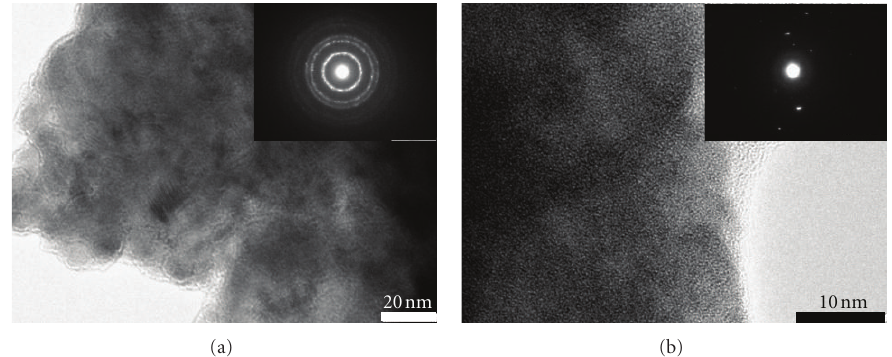
Figure 6: TEM image of spray-pyrolysis-deposited Cu-In-S with the electron di ff usion patterns (inset) on a glass/TiO 2 /In 2 S 3 substrate: (a) the major part and (b) the minor